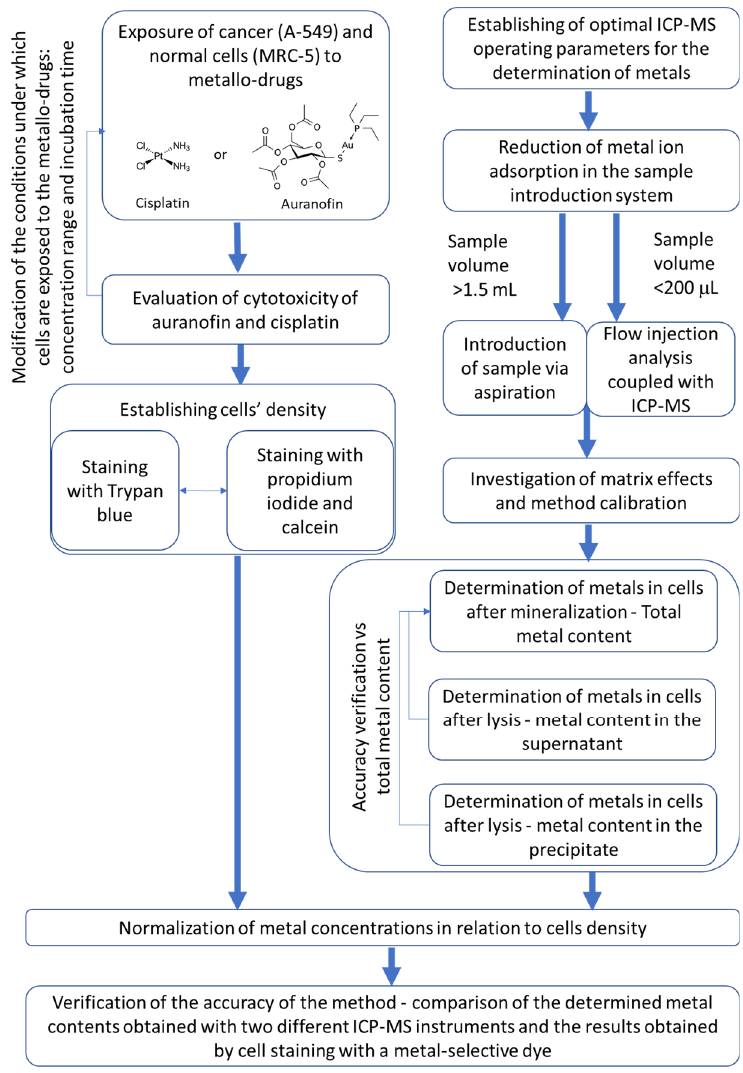
Figure 1. Schematic presentation of the procedure established to study the accumulation of metallo- drugs and their effects on the metal homeostasis in lung cancer and normal cells by ICP-MS.